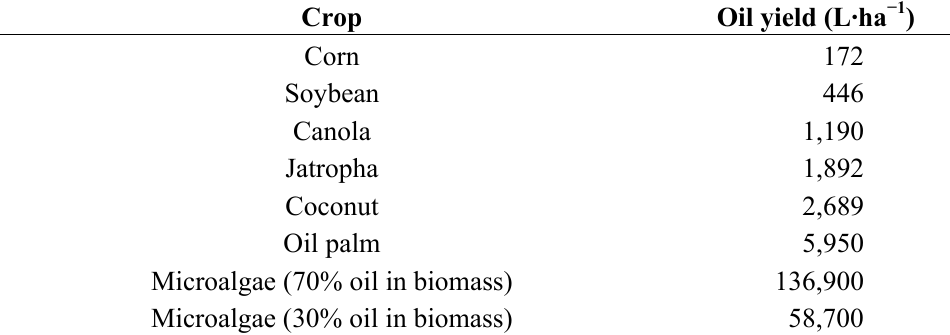
Table 1. Comparison of some sources of